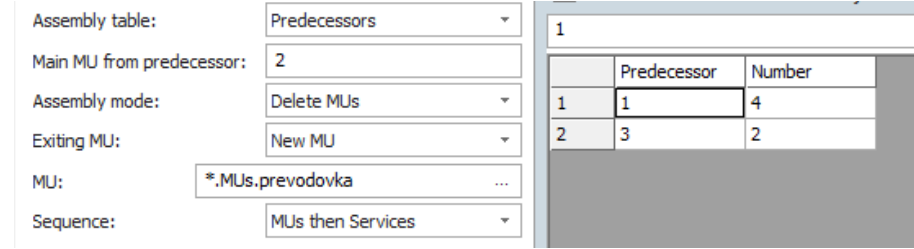
Figure 5: Setting of the block Assembly